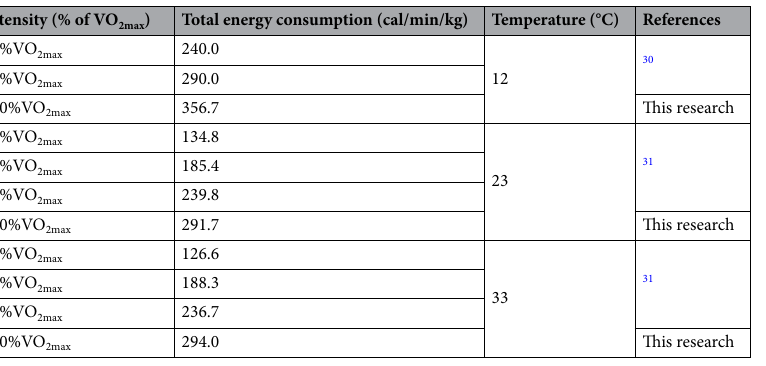
Table 1. Reference data of human of Chinese male athletes’ energy